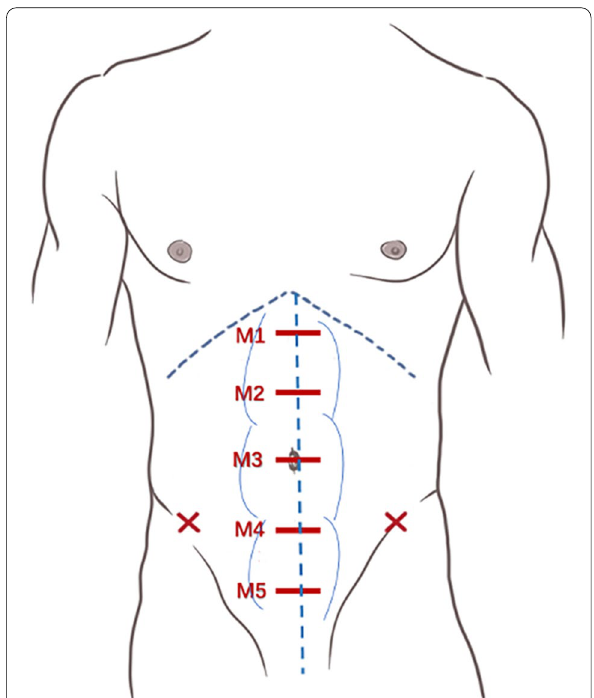
Fig. 1 Inter-rectus distance measurement at the following five locations along the midline of the abdomen: subxiphoidal, epigastric, umbilical, infraumbilical, and suprapubic